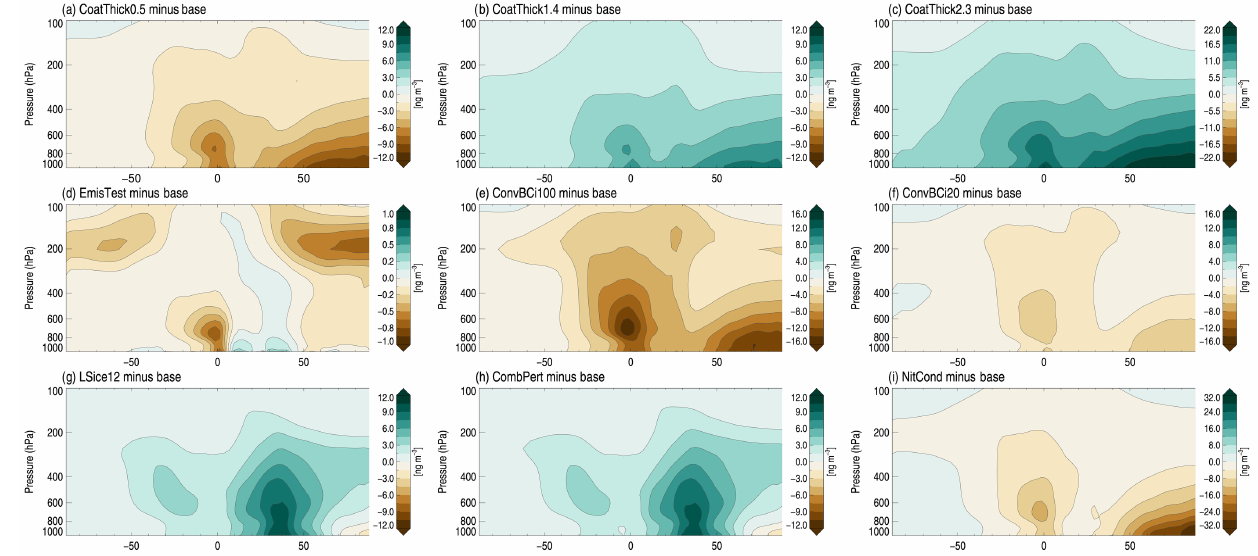
Figure 3. Difference in zonal, annual mean burden between each sensitivity experiment and the baseline simulation.